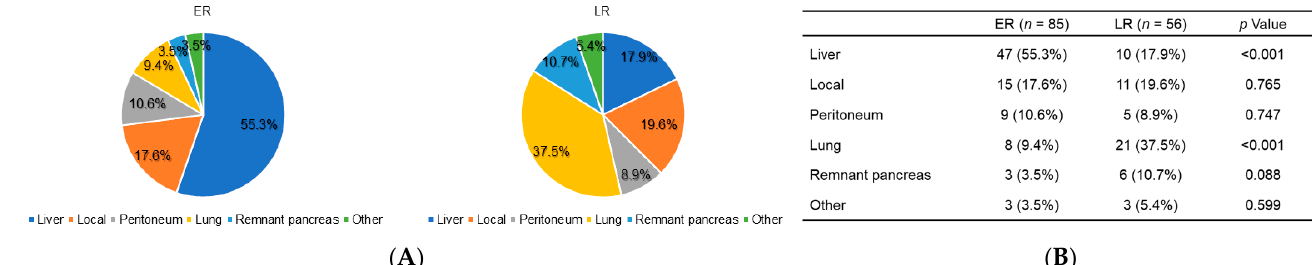
Figure 2. Kaplan–Meier curves of postrecurrence survival according to the time of recurrence.